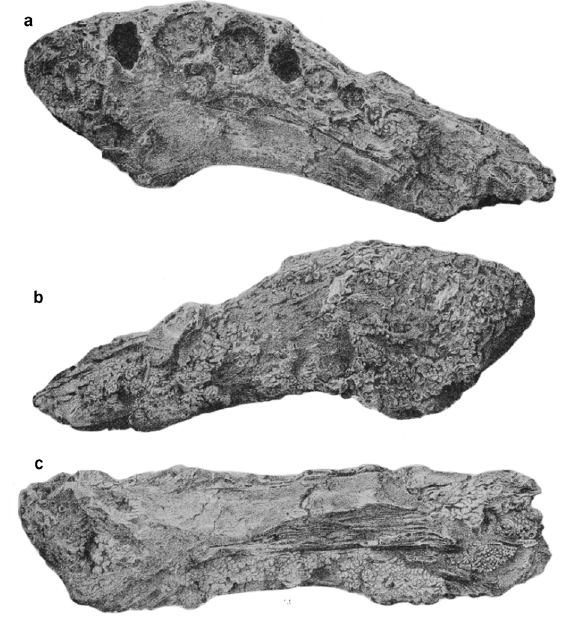
Figure 3. The mandible specimen of Purussaurus brasiliensis (DGM 527-R) and their respective schematic drawing. a) dorsal (occlusal) view; b) right lateral view; and, c) posterior view of the mandibular symphysis. Scale bar: